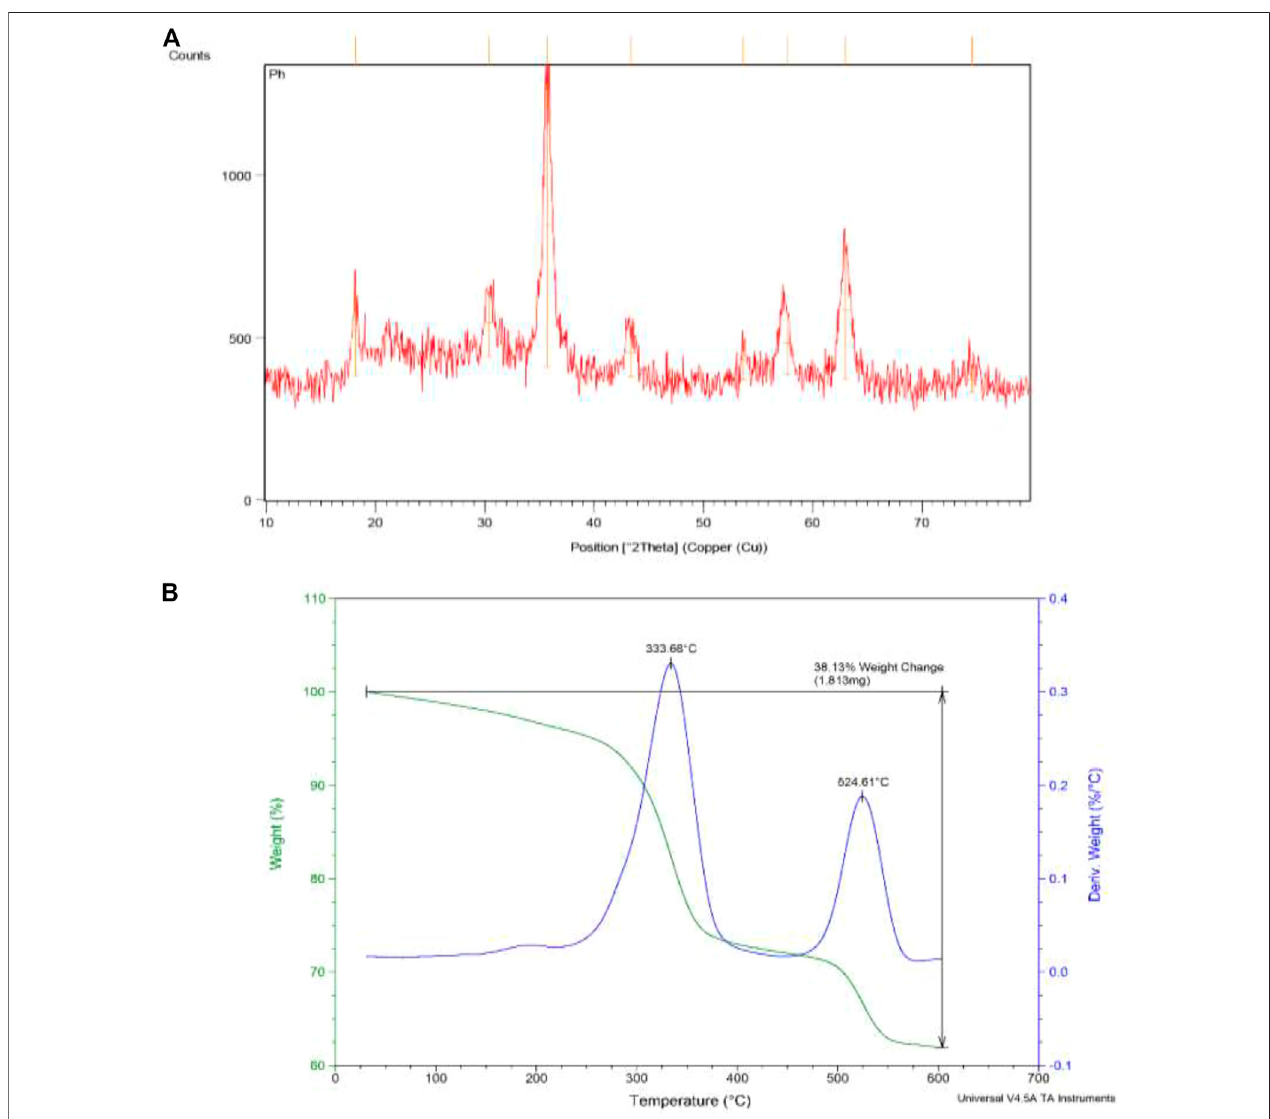
FIGURE 3 | (A) The XRD and (B) thermogravimetry analysis of synthesized nanoparticles Fe 3 O 4 @SiO 2 -propyl@dapsone-Cu complex.